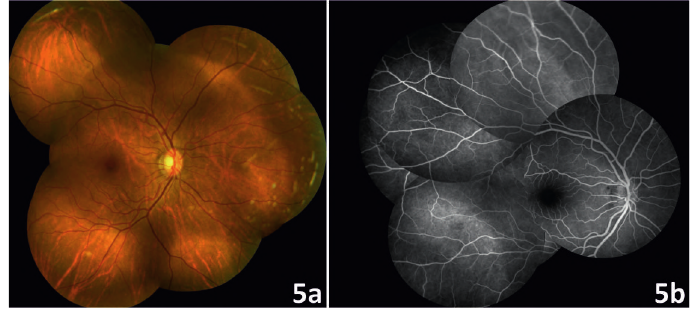
Figure 5. a,b. Colour fundus photograph and Fluorescein angiography of the right